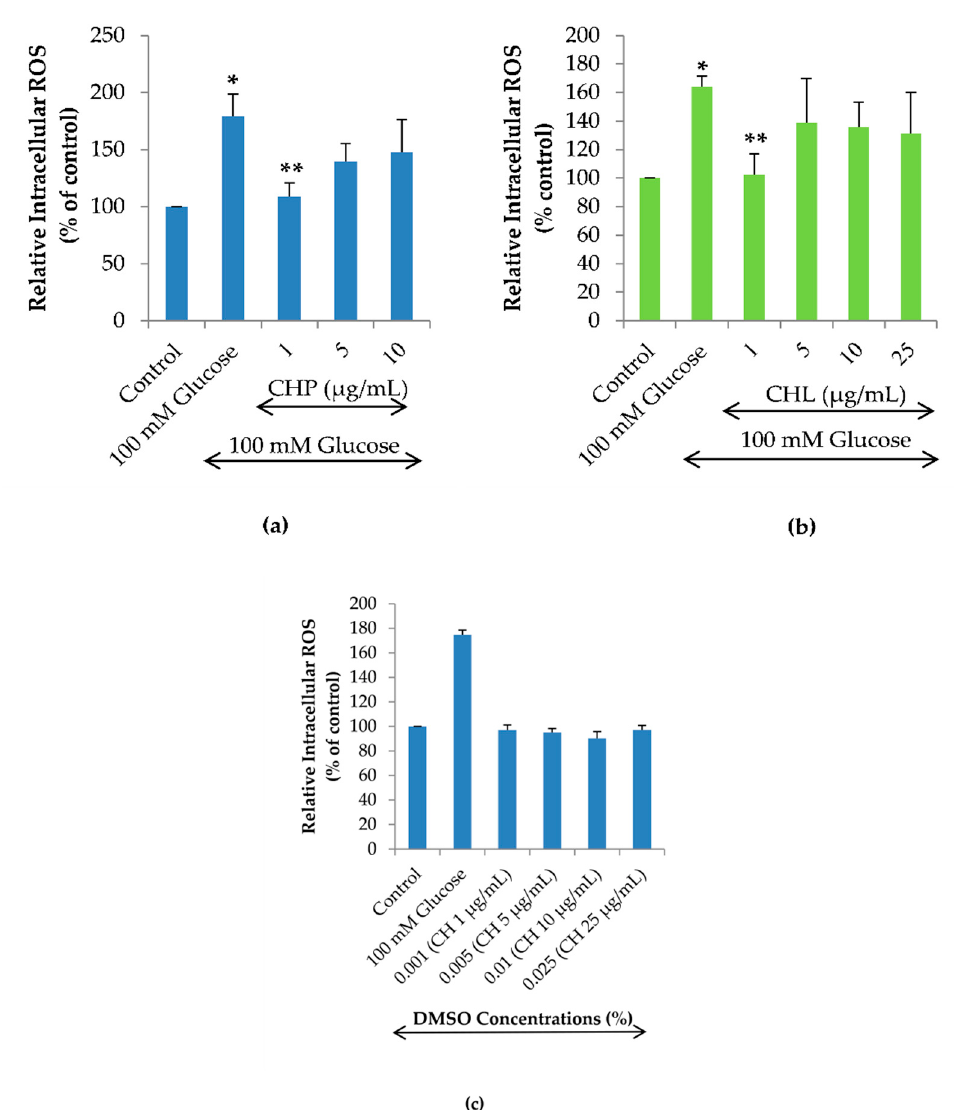
Figure 6. Effects of the extracts on high glucose-induced ROS accumulation in SH-SY5Y cells. Relative intracellular ROS level of SH-SY5Y cells treated with 100 mM glucose alone or combined with different concentrations for either CHP ( a ) or CHL ( b ) for 24 h. The effect of DMSO on relative intracellular ROS level of SH-SY5Y cells treated with (0.001 to 0.025 % ( v / v )) DMSO alone ( c ). Data are presented as the means ± SD, * p < 0.05 vs. control; ** p < 0.05 vs. 100 mM glucose alone. For CHP, p value was 0.002 in both 100 mM glucose and 1 µ g / mL groups. For CHL, p value was 0.000 in both 100 mM glucose and 1 µ g / mL groups.